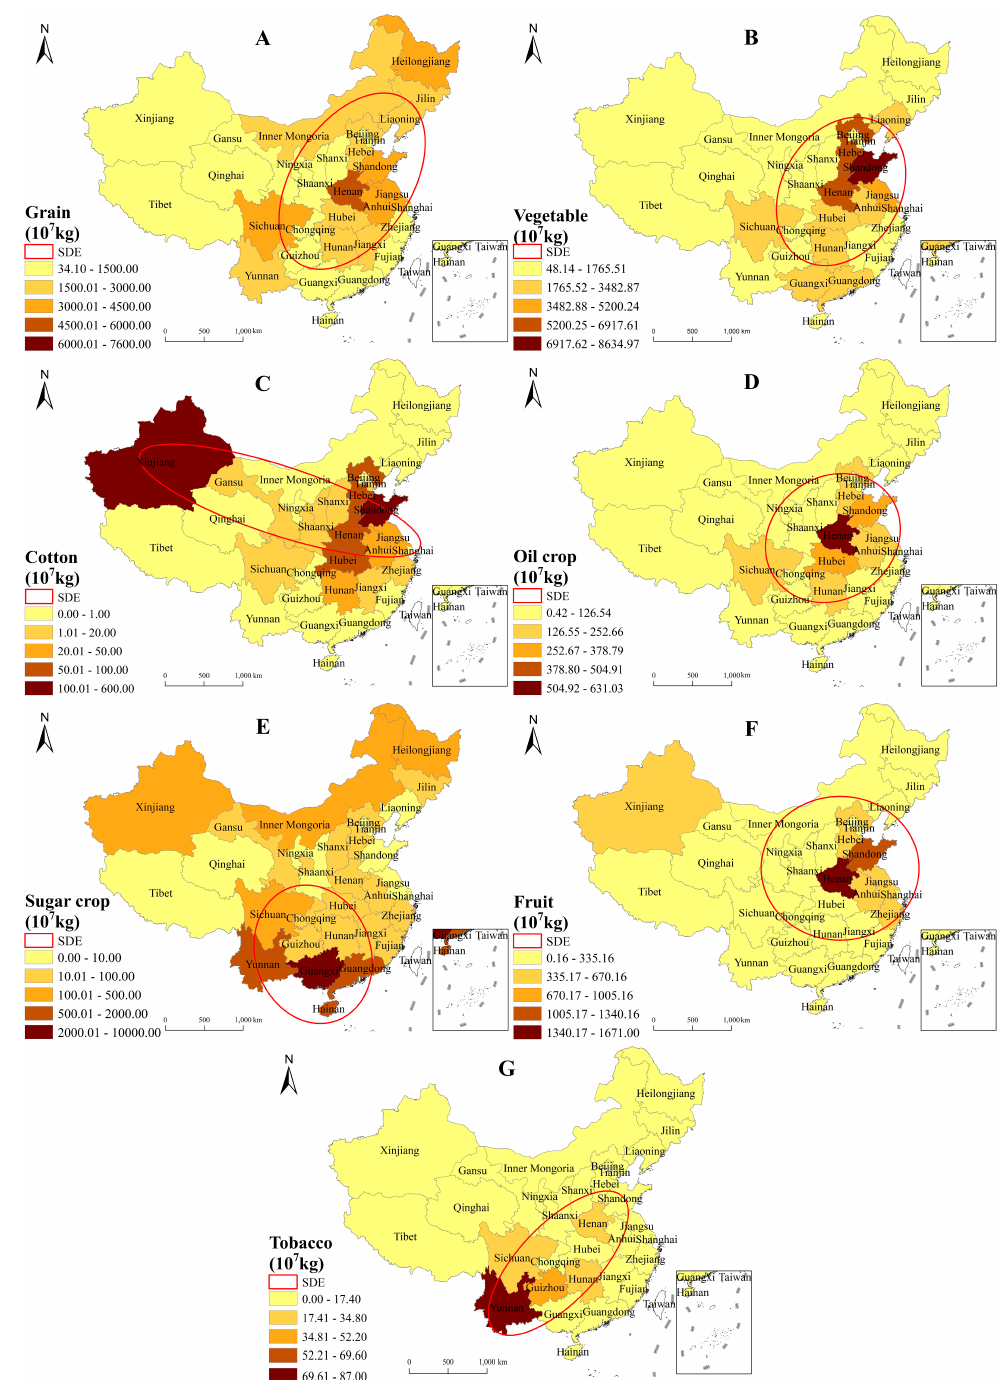
Figure 6. Output of crop yields on arable land in 2008.